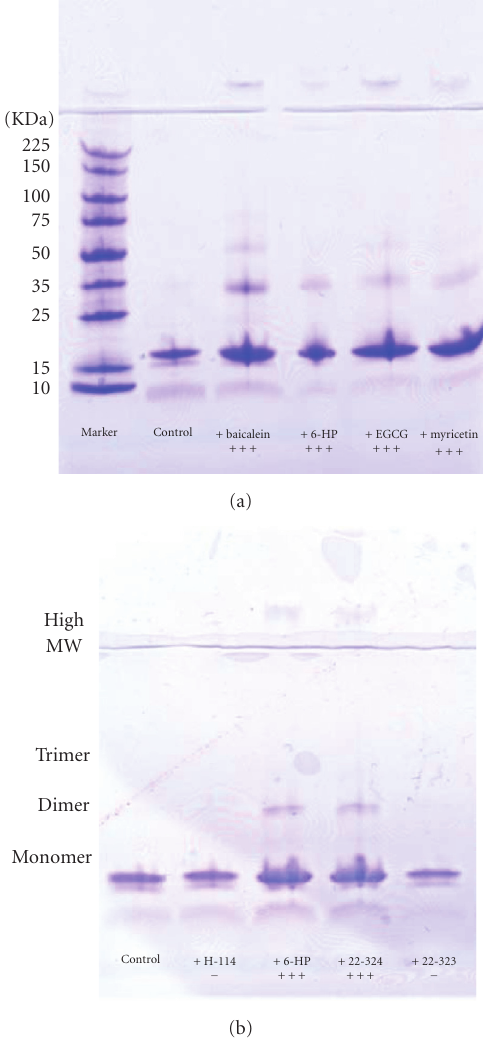
Figure 7: (a) SDS-PAGE from the supernatants of the incubated samples of α -synuclein in the absence and presence of the strong inhibitory flavonoids. (b) Comparison of the e ff ect of strong inhibitory flavonoids (6-HP, 22-324) with noninhibitory flavonoids (H-114, 22-323) on formation of stabilized soluble